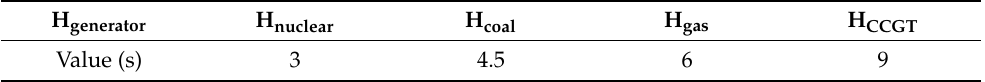
Table 2. Different generation systems with respective inertia